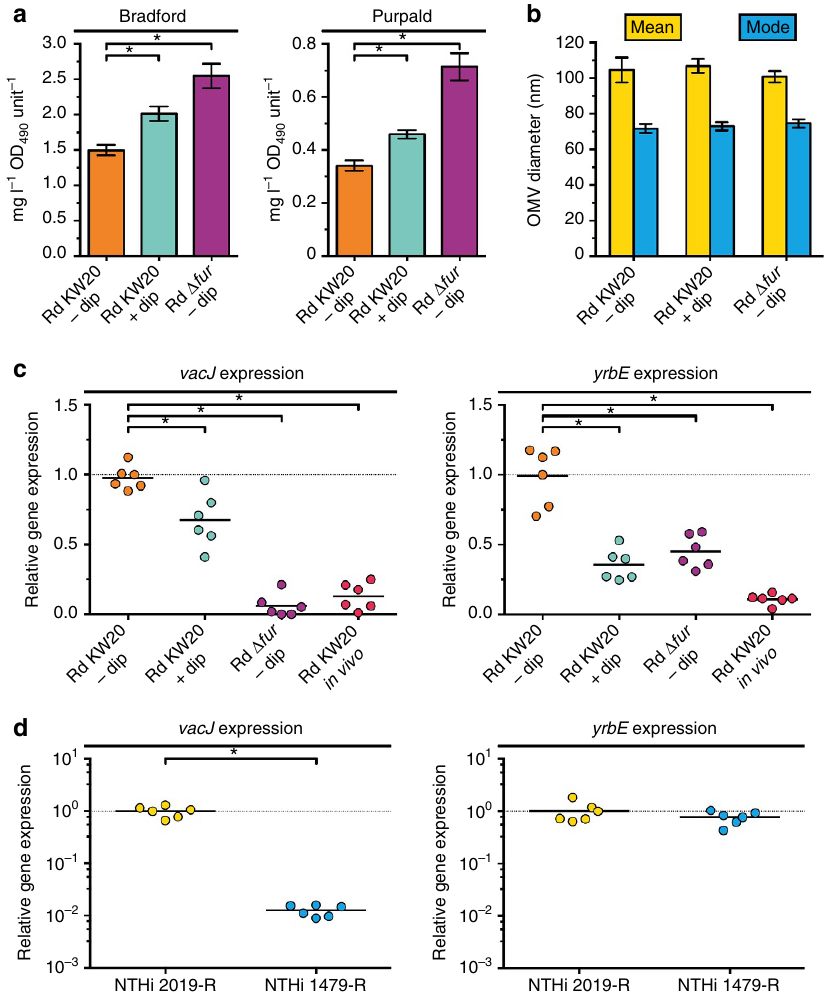
Figure 5 | Regulation of vacJ and yrbE expression in H. influenzae . ( a ) OMVpreparations derived from equivalent OD 490 units of cultured Rd KW20 or Rd D fur grown in BHI–NAD–hemin supplemented without ( (cid:2) dip) or with ( þ dip) 2,2 0 -dipyridyl were analysed for total protein (Bradford) and lipooligosaccharide (Purpald). Mean values with s.e.m. are shown ( n ¼ 6 biological replicates). ( b ) Distributions of OMV sizes produced by the strains in different culture conditions were determined by nanoparticle tracking analysis. Mean values with s.d. of mean and mode OMV diameter sizes within respective OMV preparations are shown ( n ¼ 6 biological replicates). ( c ) Relative expressions of vacJ and yrbE in Rd KW20 or Rd D fur grown in BHI–NAD– hemin supplemented without ( (cid:2) dip) or with ( þ dip) 2,2 0 -dipyridyl as well as in Rd KW20 after colonization of the mouse nasopharynx for 4h ( in vivo ) were determined by qRT-PCR. ( d ) Relative expressions of vacJ and yrbE in NTHi 2019-R and NTHi 1479-R grown in BHI–NAD–hemin were determined by qRT-PCR. ( c , d ) Horizontal bars highlight the mean of each data set ( n ¼ 6 biological replicates). Dotted lines indicate a relative gene expression of 1. ( a , c , d ) Significant differences between the data sets are marked by asterisks ( P o 0.05; one-way ANOVA followed by Sidak’s multiple comparison post test ( a,c ) or unpaired t -test ( d